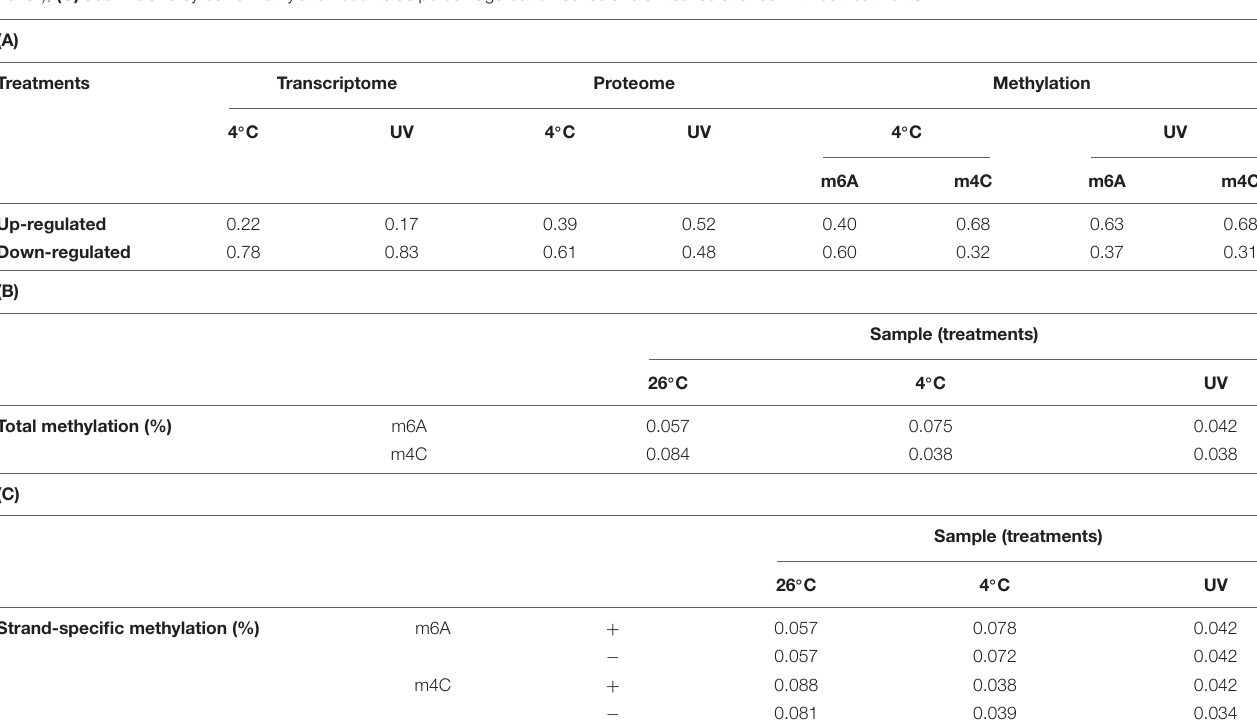
TABLE 2 | Table showing relative variation in the transcriptome, proteome, and in the adenine and cytosine methylation counts as compared to the control (26 ◦ C incubation); (B) Tabulation of adenine and cytosine methylation counts in the genome (as percentage) in three treatments (i.e., warm, cold, and UV irradiation, i.e., 26 ◦ C*); (C) adenine and cytosine methylation counts as percentage but on sense and antisense strands in three